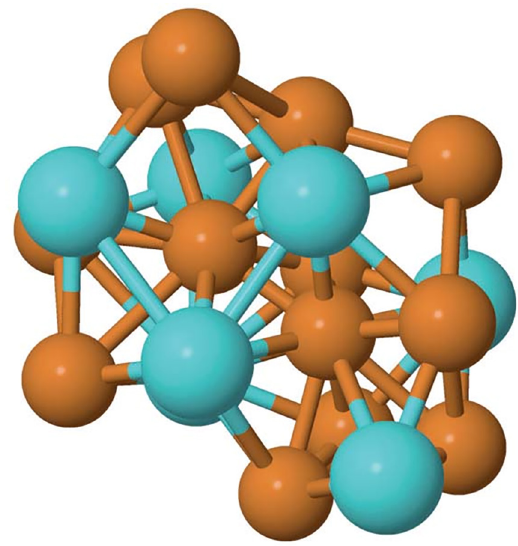
Figure 9. A case of 20-atom supercluster. 112